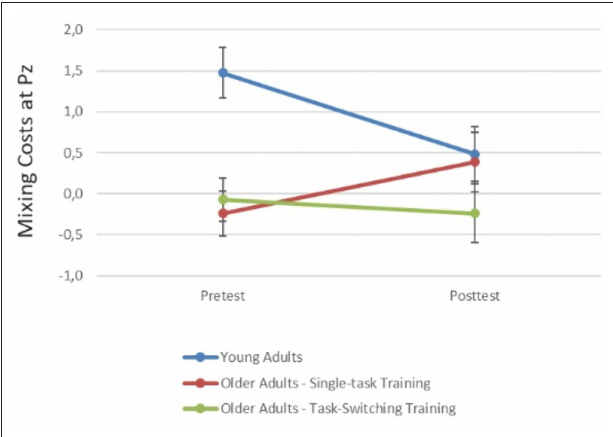
FIGURE 5 | Mixing costs (calculated as the difference between single trials and the mean of repeat and switch trials) in early cue-locked P3 amplitudes at electrode Pz for pre- and post-test. Smaller values reflect smaller mixing costs. Error bars refer to standard errors of the mean. Mixing costs seem to decrease from pre- to post-test for younger adults and older adults from the task-switching training group, while they show a tendency to increase for older adults from the single-task training